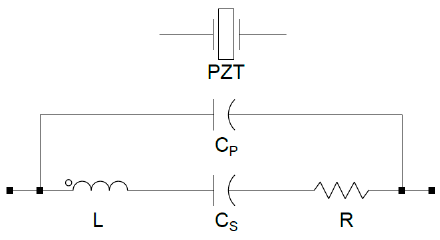
Figure 7. Quartz piezoelectric harvester equivalent circuit.